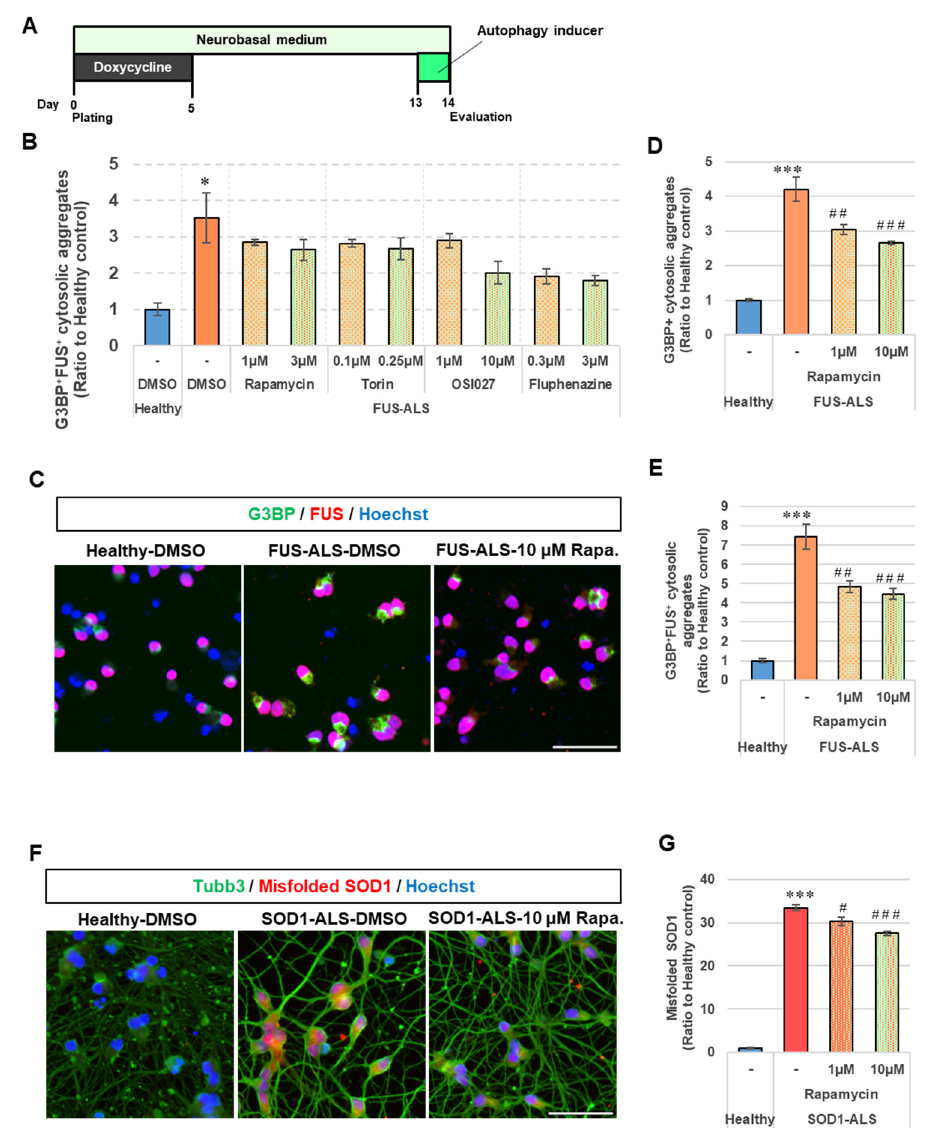
Figure 3. Effect of autophagy inducers on protein accumulation in ALS neurons. ( A ) Overview of the evaluation system for autophagy inducers. ( B ) The effect of autophagy inducers on FUS+ stress granules in FUS- ALS neurons was evaluated. Accumulation of FUS + G3BP+ cytosolic aggregates in FUS- ALS neurons was normalized to that of healthy control ( n = 3, mean ± SEM). ( C ) Representative images of iPSC-derived motor neurons immunostained for G3BP (green), FUS (red), and Hoechst 33342 (blue). The scale bar represents 50 µ m. The effect of rapamycin on ( D ) G3BP+; and ( E ) FUS + G3BP+ stress granule formation was evaluated. Accumulation levels of stress granules in FUS -ALS neurons were normalized to that of healthy controls ( n = 5, mean ± SEM). ( F ) Representative images of iPSC-derived motor neurons immunostained for Tubb3 (green), misfolded SOD1 (red), and Hoechst 33342 (blue). The scale bar represents 50 µ m. ( G ) The effect of rapamycin on SOD1 accumulation was evaluated. Accumulation levels of SOD1 in SOD1 -ALS neurons were normalized to that of healthy controls. ( n = 5, mean ± SEM). *: p < 0.05 vs. healthy control ( t -test), ***: p < 0.001 vs. healthy control ( t -test); #: p < 0.05 vs. vehicle control (Dunnett test), ##: p < 0.01 vs. vehicle control (Dunnett test), ###: p < 0.001 vs. vehicle control (Dunnett